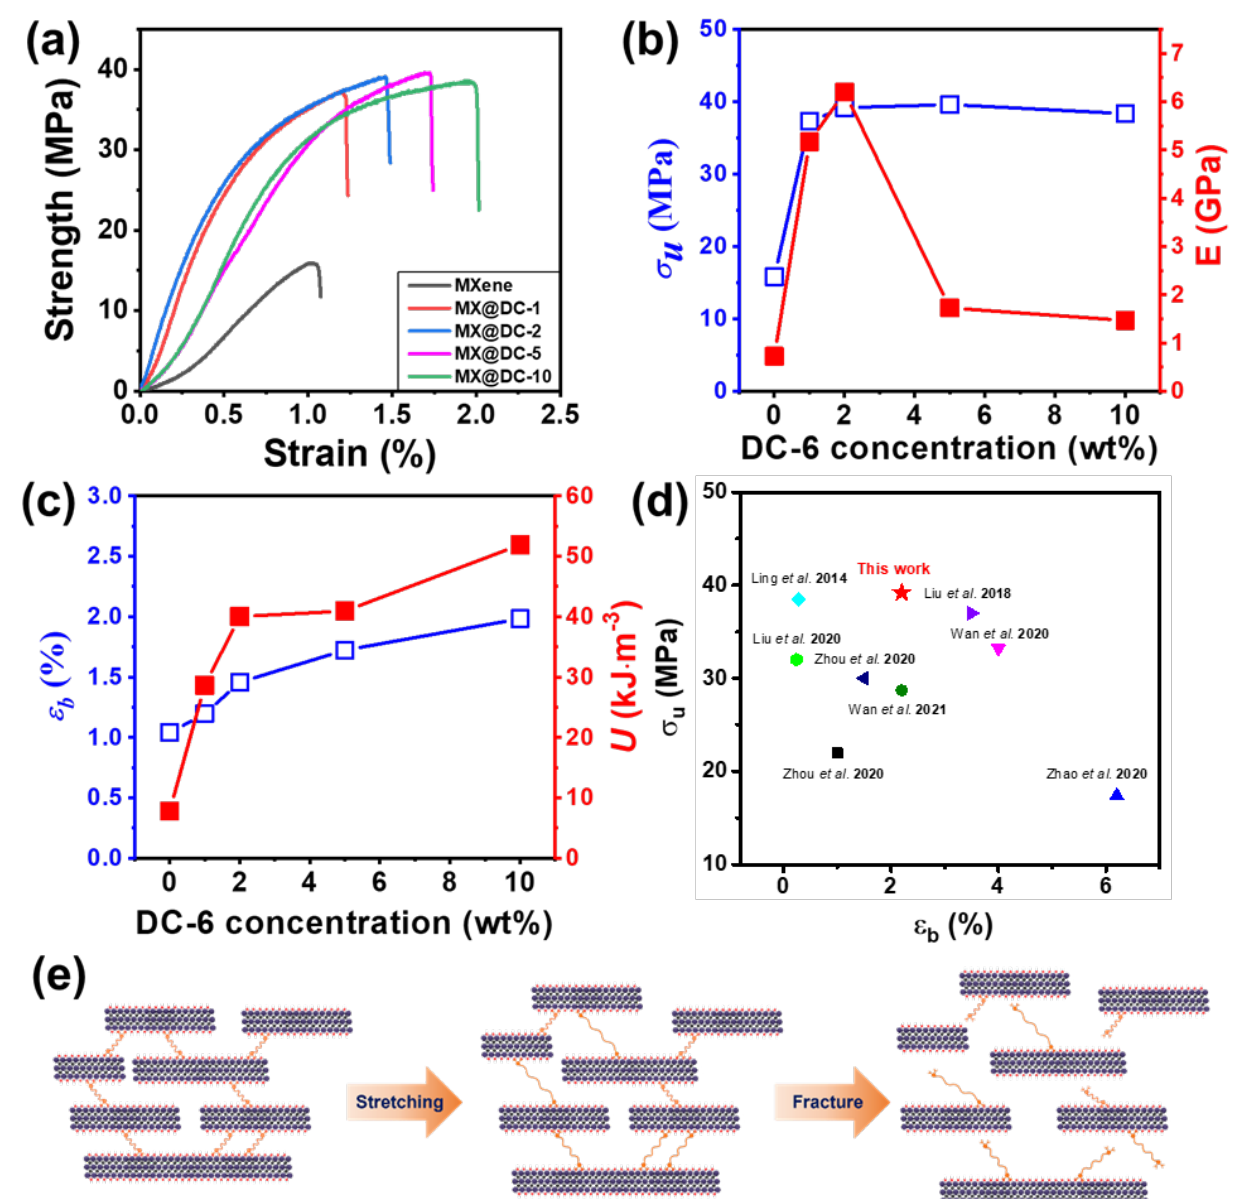
Figure 4. ( a ) Stress − strain curves of the MXene and MX@DC − x films as a function of DC content, ( b ) the ultimate strength and Young’s modulus, ( c ) elongation at break and toughness of the MXene and MX@DC − x films as a function of DC content, respectively. ( d ) Comparison of tensile strength of treated MXene films between our work and the previous works [28,29,41,53–57], ( e ) Illustration of the fracture of MX@DC − x film during tension test.